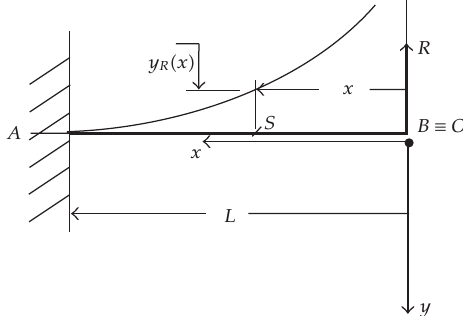
Figure 3: Horizontal cantilever rod bent under tip-concentrated upwards